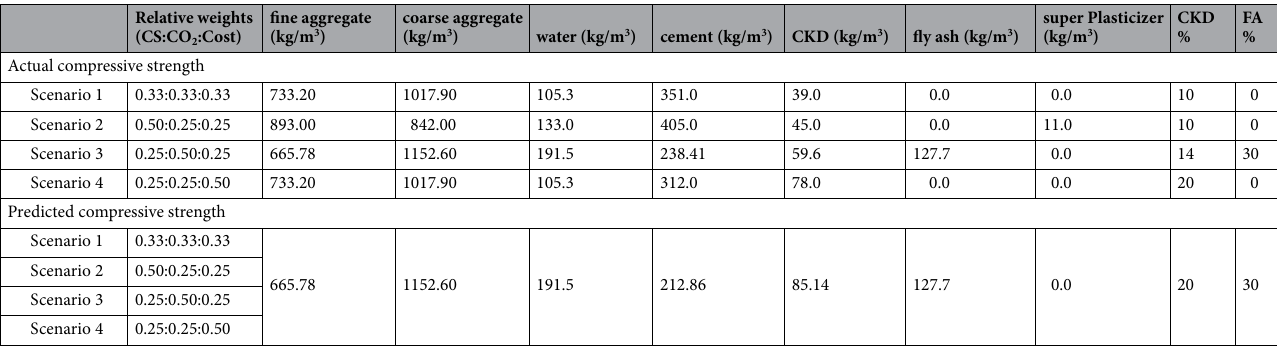
Table 8. Optimum Mixtures based on the several